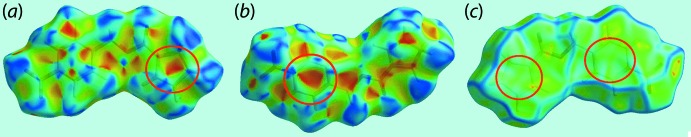
(a) Views of the Hirshfeld surface for (I) mapped over the shape-index property highlighting blue regions about bright-red spots within the (a) pyrrolyl and (b) benzene rings, and (c) the Hirshfeld surface mapped over curvedness indicating flat regions around the pyrrolyl and benzene rings. The respective rings are highlighted by the red circles.